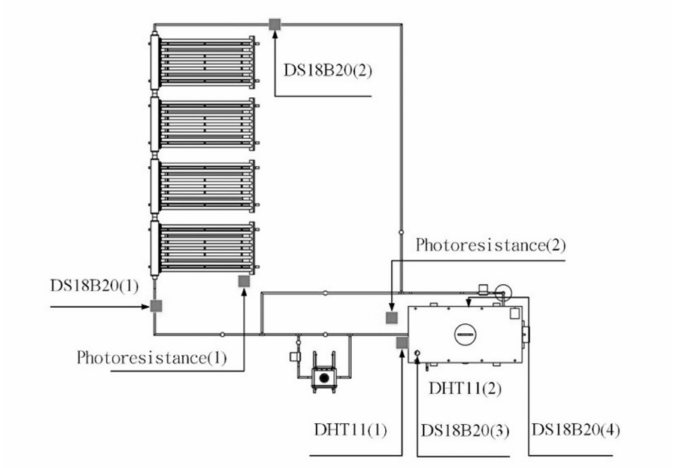
Figure 7. Photoresistor placement